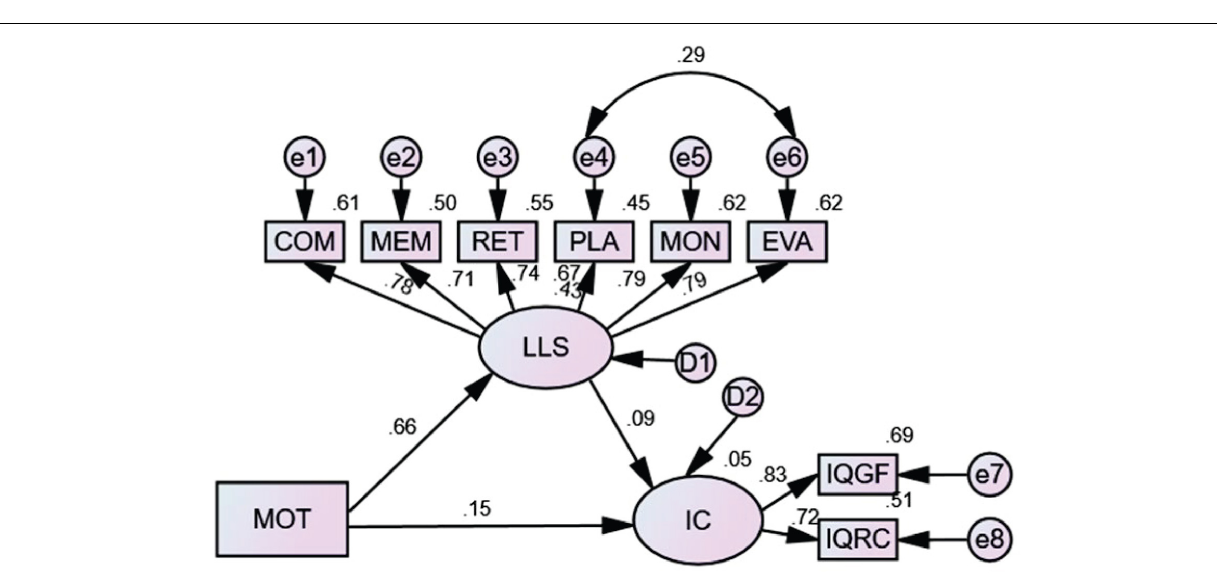
FIGURE 2 | Structural model of the relationships between motivational strategies, language learning strategies and inferential comprehension. LLS, language learning strategies; COM, comprehending; MEM, memory; RET, retrieval; PLA, planning; MON, monitoring; EVA, evaluating; MOT, motivational strategies; IC, inferential comprehension; IQGF, inferential questions in gap-filling; IQRC, inferential questions in reading